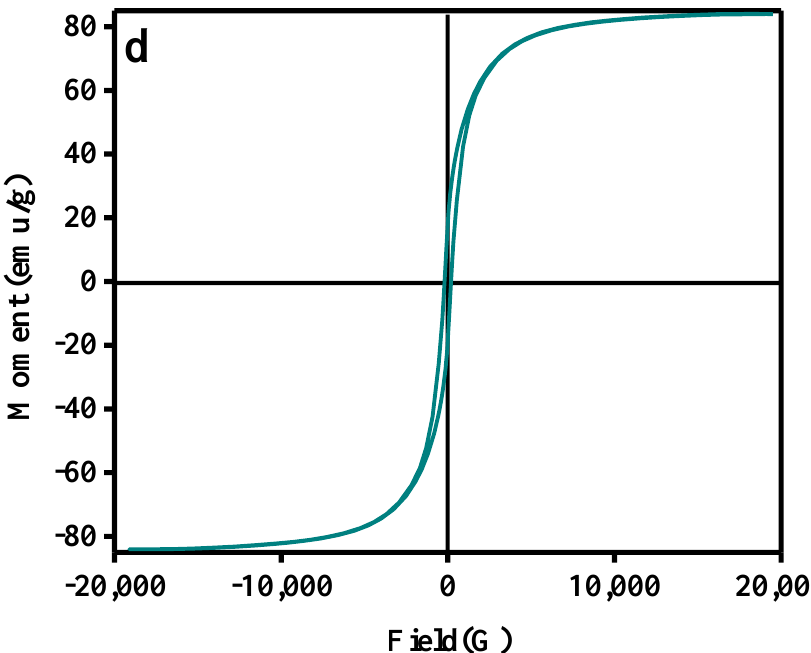
Figure 3. Characterization of FeNi MANPs. ( a ) UV–Vis spectrum; ( b ) BET isotherm (inset shows an enlargement of the hysteresis gap); ( c ) TEM image for the prepared MANPs, and the inset shows particle size distribution; and ( d ) magnetic hysteresis loop of the FeNi MANPs at 298 K.